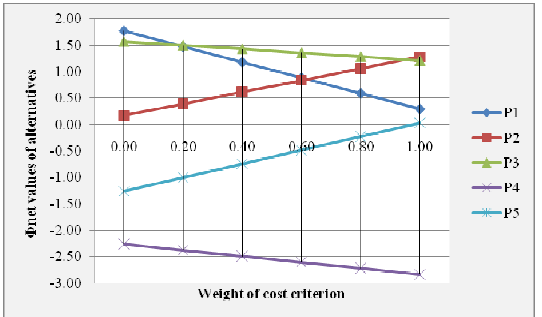
Figure 10. The change in the Φ net values of alternatives with the change in the weight of cost criterion After the investigation on sensitivity analysis, it can be said that the evaluations are sensitive to the weights of the criteria. Following the sensitivity analyses phase, the results are presented to the DMT and DMT found convenient to buy the best alternative which is